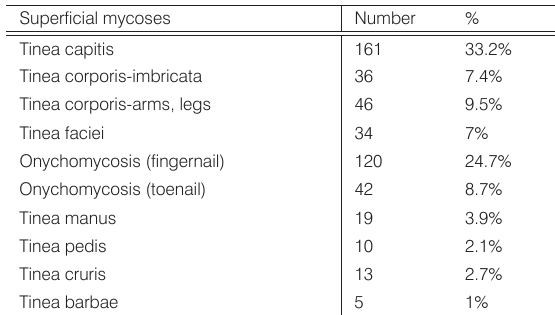
Table 2 Prevalence of superficial